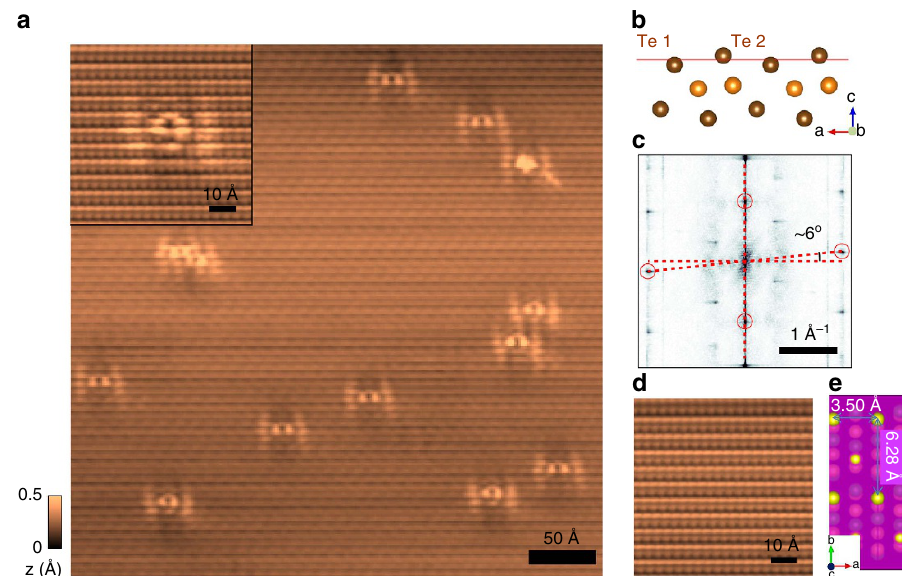
Figure 1 | Surface topography and structure of WTe 2 . ( a ) Topographic image of a 400Å (cid:2) 400Å area on the (001) surface of WTe 2 with several ‘tie-fighter’-like impurities ( V bias ¼ (cid:3) 80mV, I tunneling ¼ 100pA and T ¼ 30K). Inset: Zoom-in on an individual defect. ( b ) Side schematic view of the WTe 2 lattice highlighting the two inequivalent Te atoms. ( c ) Fourier transform of the topograph in a reveals Bragg peaks corresponding to the atomic corrugation (red circles indicate the first-order Bragg peaks) and the anomalous angle between the crystallographic axes on the surface (6 (cid:2) in this sample). The degree of the angular distortion varied a few degrees between different samples. ( d ) Zoom-in on a clean area displays the surface Te atoms. ( e ) Top schematic view of the WTe 2 (001) surface highlighting the surface Te atoms and the unit cell